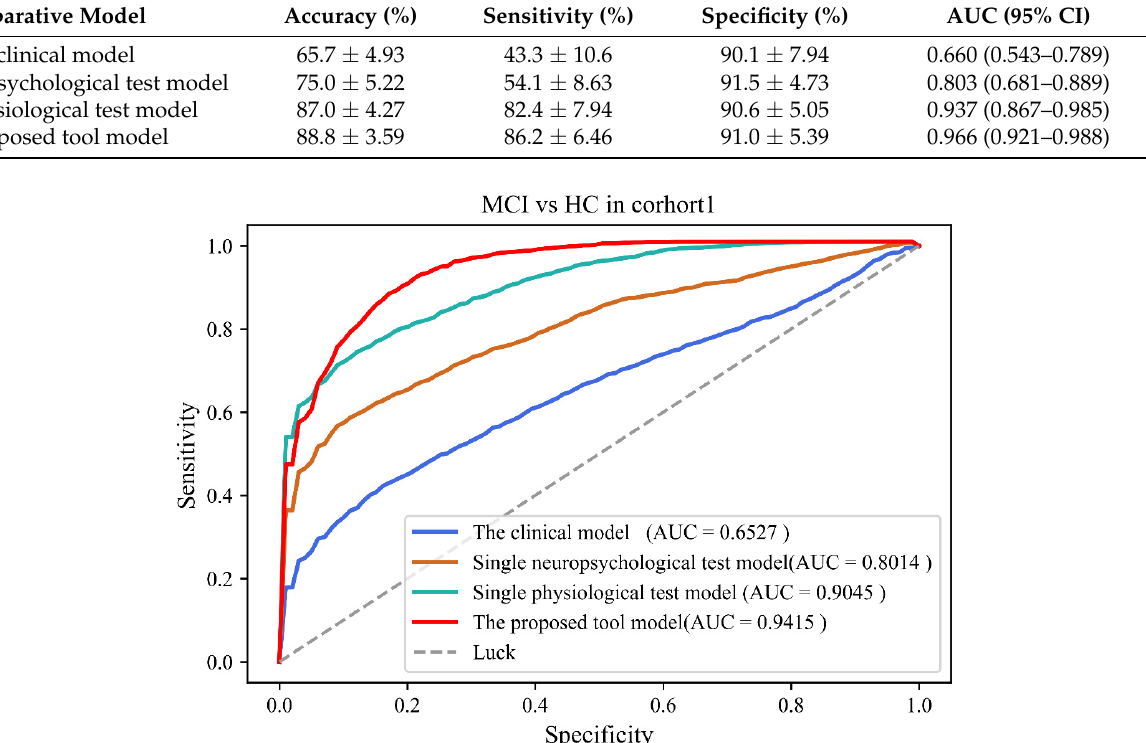
Figure 2. The receiver operating curves of four models in cohort 1.